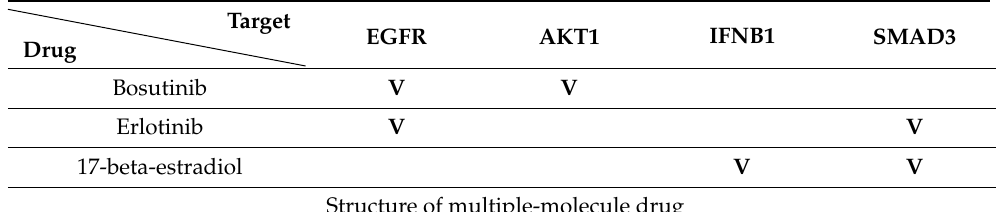
Table 6. The proposed potential multiple-molecule drug with the corresponding targets for disrupting the progression of the amplification stage of SARS-CoV-2 infection.